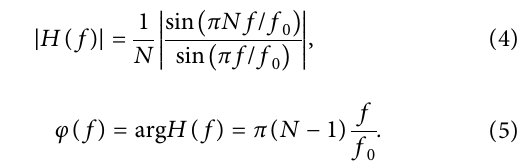
Figure 3: The implementation flow chart. T is the rotation period of rotary machinery, which is generally used as the truncation